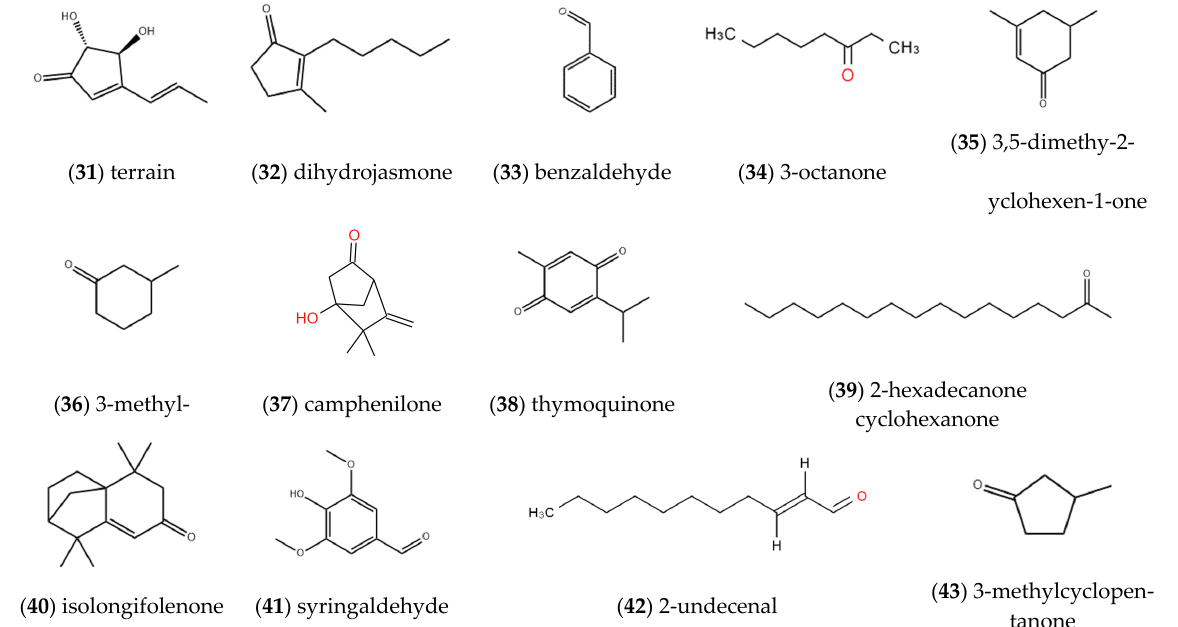
Figure 3. Structures of aldehydes, ketones and quinones isolated from ST .